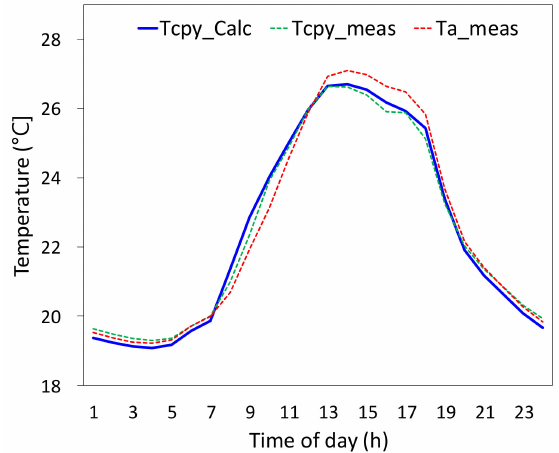
Figure 12. Scatterplot of canopy temperatures from model calculations and actual measurements. R 2 is the adjusted correlation coefficient.